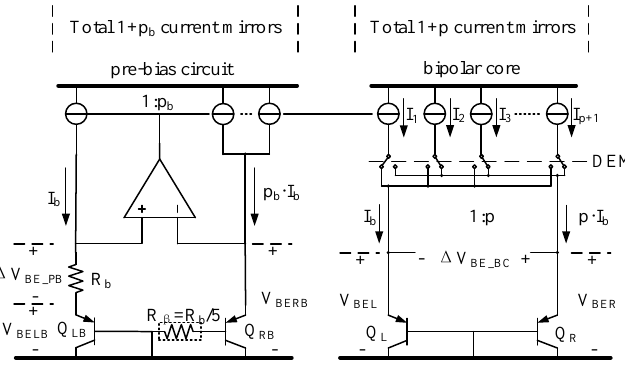
Figure 1. Conventional bipolar junction transistor (BJT) based temperature sensor front-end circuit.